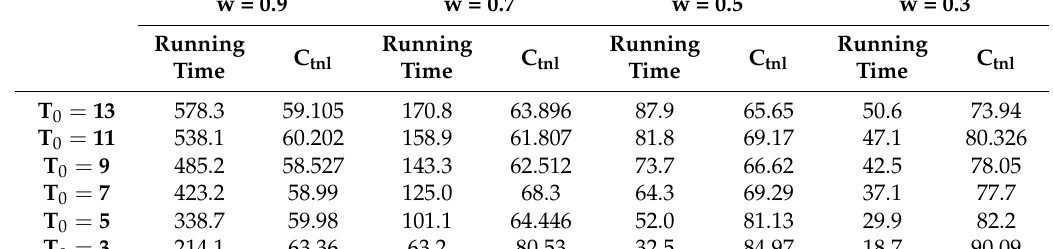
Table 2. The running time (in milliseconds) and C tnl (in meters) with different annealing speeds and initial temperatures. w = 0.9